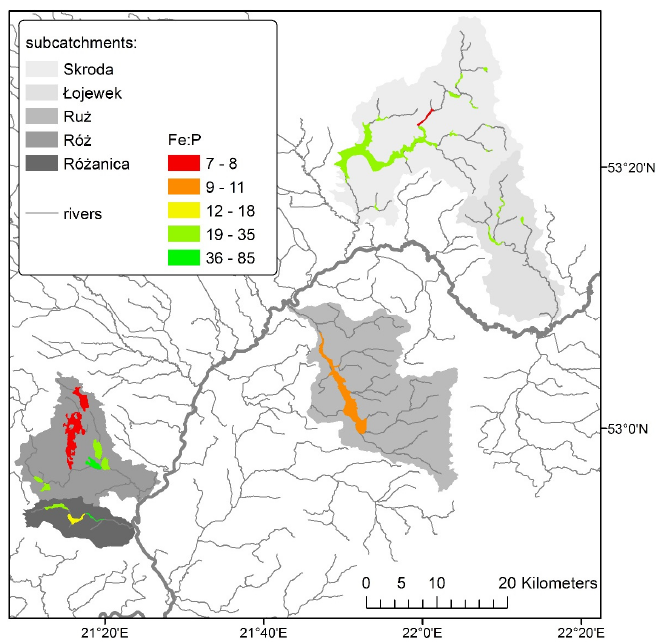
Figure 3. Extrapolated average molar ratio Fe BD :P BD in peatlands in sub-catchments.